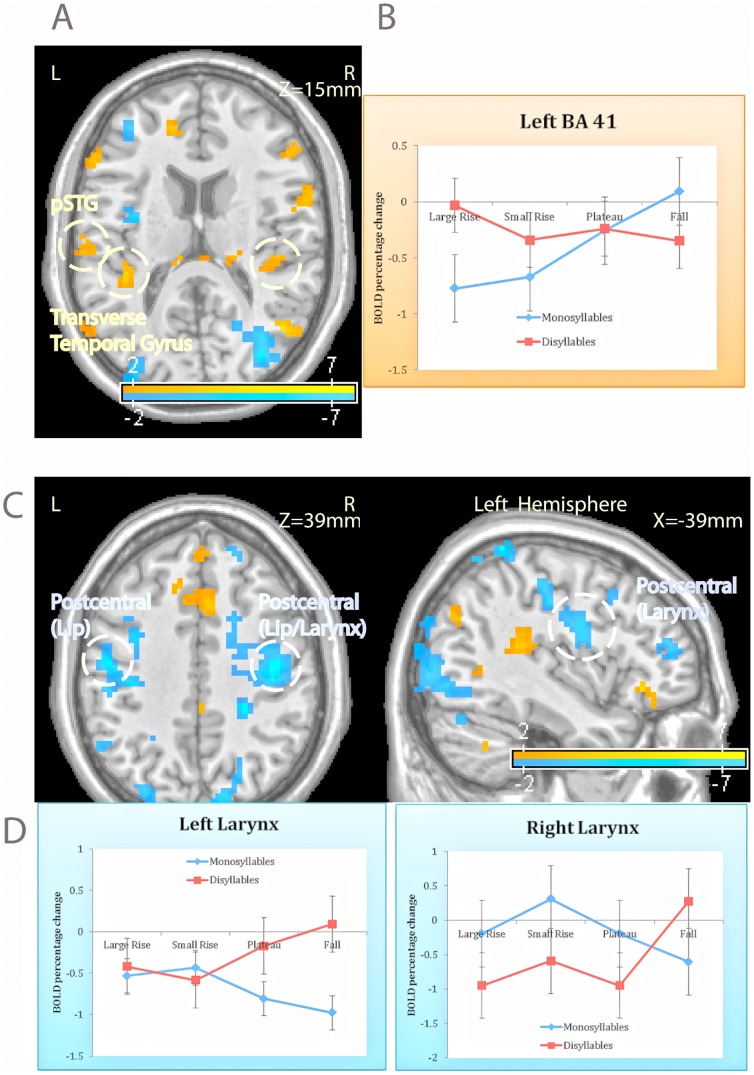
The effect of syllable hierarchy in sensorimotor speech areas.The syllable structure manipulation activated primary auditory cortex (A), and this effect was specifically due to the structure of monosyllables (B). Syllable structure also modulated hemodynamic response in motor areas (C), but these effects, significant at the larynx area, resulted in deactivation (D). Responses to monosyllables are plotted in blue; disyllables are indicated in red.